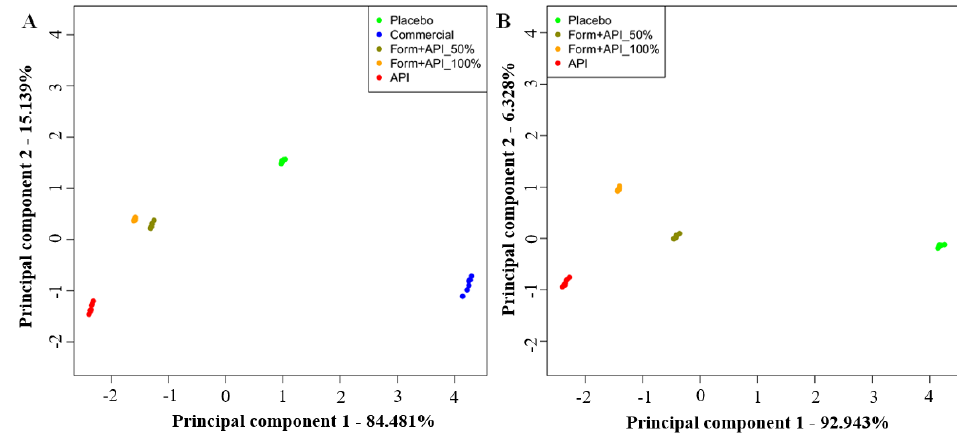
Figure 7. Principal component (PC) analysis score plot of the results of the e-tongue tests presenting the taste profile comparison of ( A ) all the five tested samples and ( B ) without the Commercial sample.